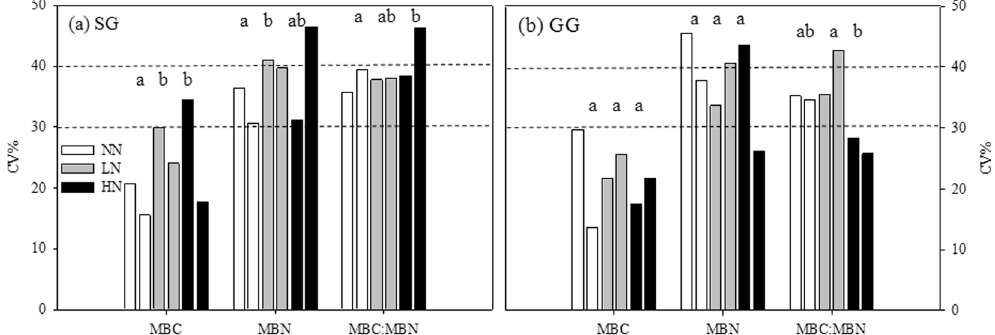
Figure 3. Within-plot CVs of MBC (mgC/g soil ), MBN (mgN/g soil ) concentrations, and MBC:MBN under three N fertilization (i.e. NN, LN and HN) in ( a ) SG and ( b ) GG cropland soils in a three-year long fertilization experimental site at the Tennessee State University (TSU) Agricultural Research Center in Nashville, TN, USA. The dashed lines represent a CV of 30% and 40%. The abbreviations are referred to Table 1. Different lowercase letters denote significant difference in CV between fertilization treatments for each variable at P < 0.05.